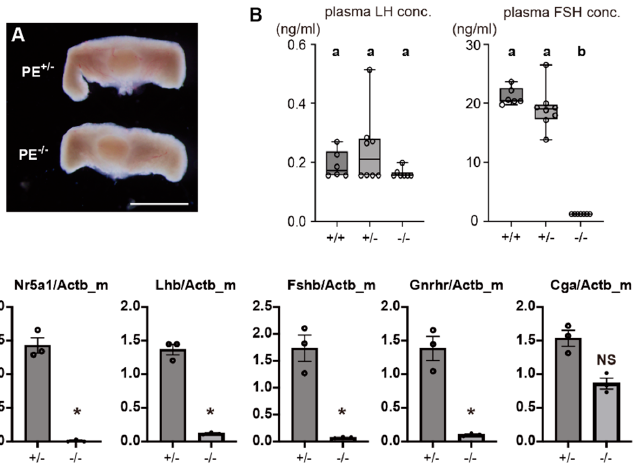
Figure 6. Changes in pituitary gonadotrope marker genes in PE − / − mice. ( A ) Macroscopic view of the pituitary glands of control and PE − / − mice. Scale bar: 1 mm ( B ) Plasma concentrations of LH and FSH